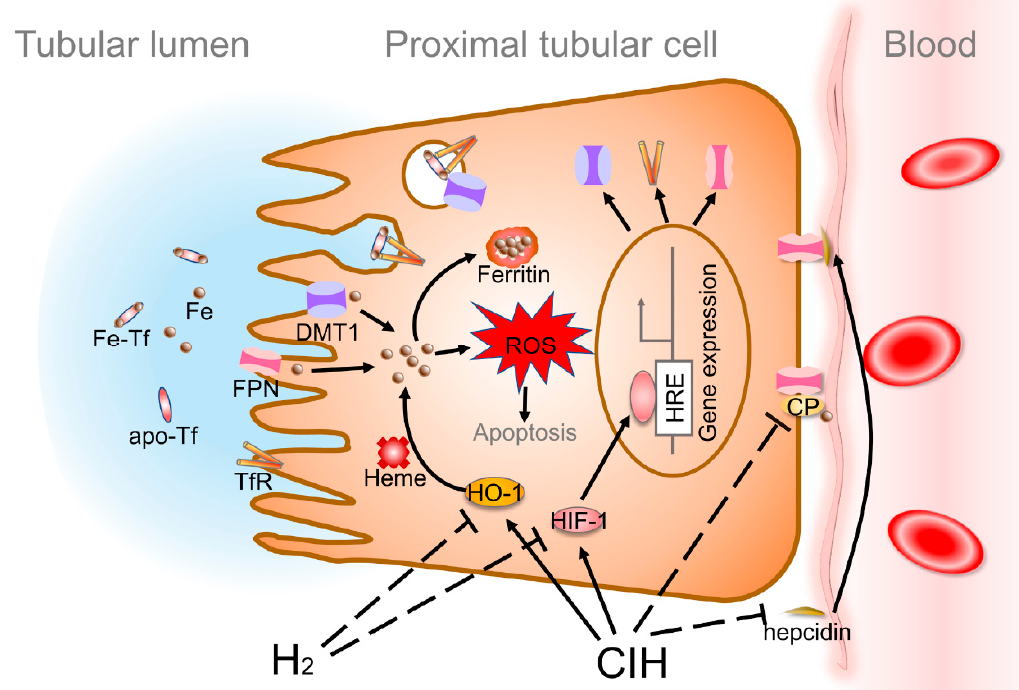
Figure 6. Proposed signaling pathways involved in the protective effect of H 2 in CIH-induced renal injury. The renal injury, apoptosis and oxidative stress induced by CIH were strikingly attenuated in H 2 treated rats. Mechanistically, hydrogen gas attenuated CIH-induced elevated expression of HIF-1 α , and downregulation of HIF-1 α blunted its binding to the hypoxia-response element (HRE) DNA sequence of target proteins such as TfR and DMT1. FPN is an oxygen-responsive gene that affected by HIF-1 and mediated by the iron-regulatory hormone hepcidin. The current renal FPN expression should be a balance of hypoxia and hepcidin. Meanwhile, CIH inhibit CP expression via promoting its mRNA decay. What’s more, H 2 suppressed CIH induced iron extracted from heme by decreasing HO-1 expression.